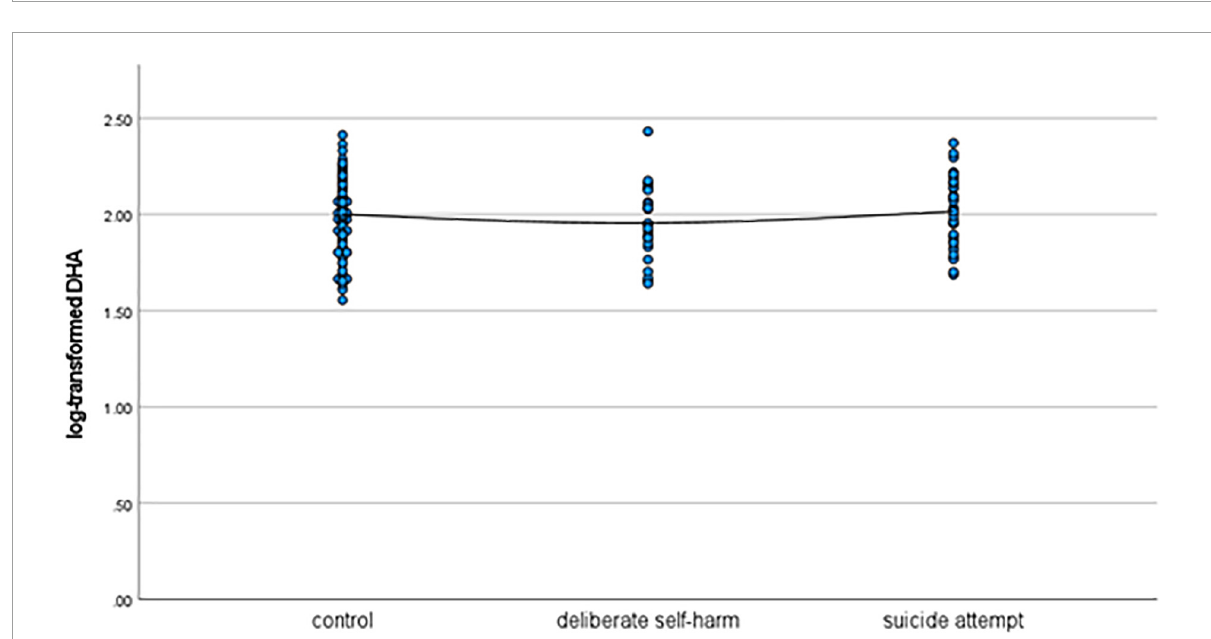
As shown in Table 4 , the third multivariate logistic regression analysis with adjustment for age, sex, and log- transformed lithium and AA levels revealed that the negative association with log-transformed lithium levels was significantly greater in patients with suicide attempts and in patients